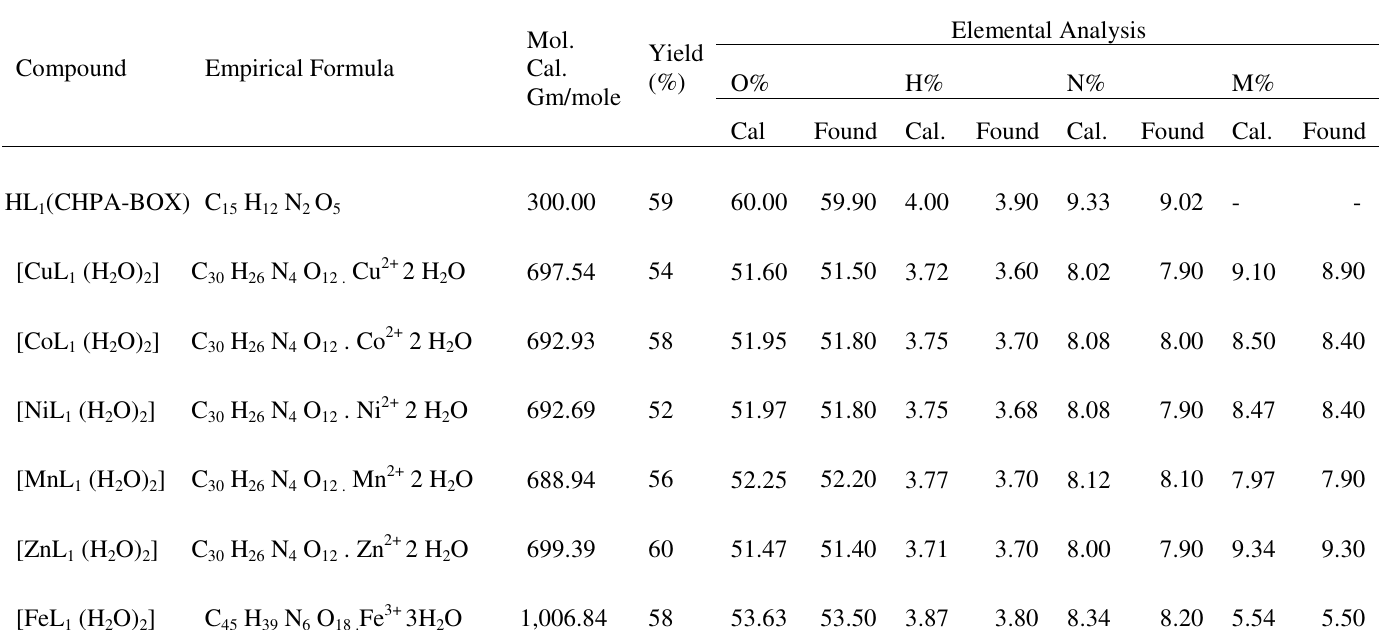
( i.e .Q CHPA - BOX) 1